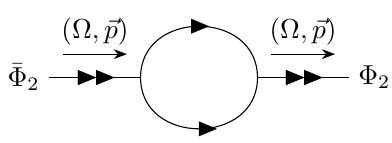
Figure 6. One-loop correction to the self-energy of (cid:8)